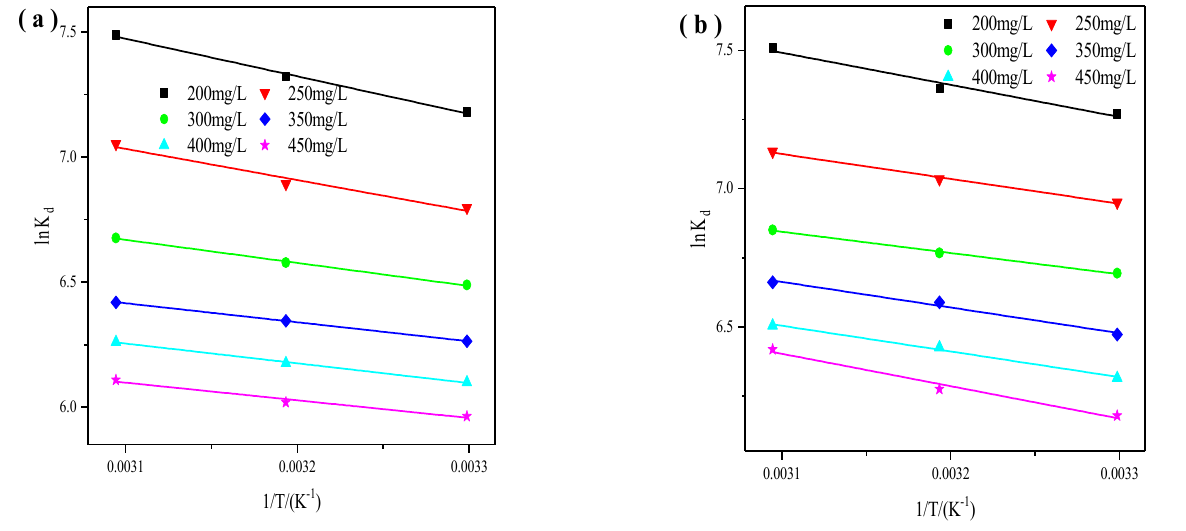
Figure 8. Plot of LnK d versus 1/T at various initial concentrations of Cu 2+ ( a ) and Zn 2+ ( b ).